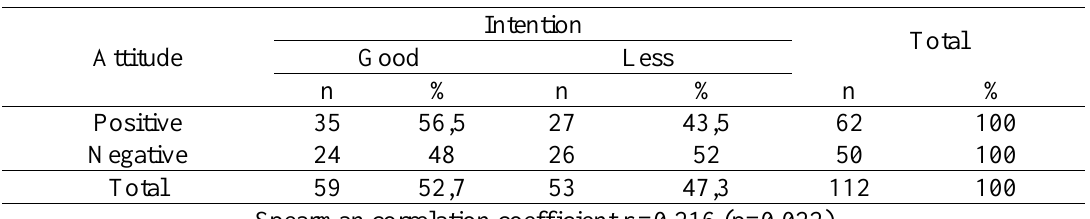
Cross Tabulation between attitude and intention In Implementation of Diabetes Mellitus Education Based on Theory of Planned Behavior in Public health center around Surabaya